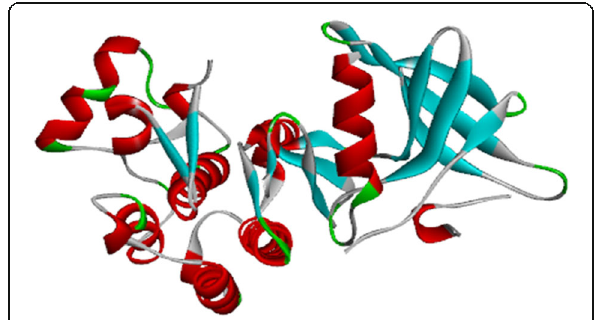
Fig. 4 The 3D prepared structure of the EGFR receptor